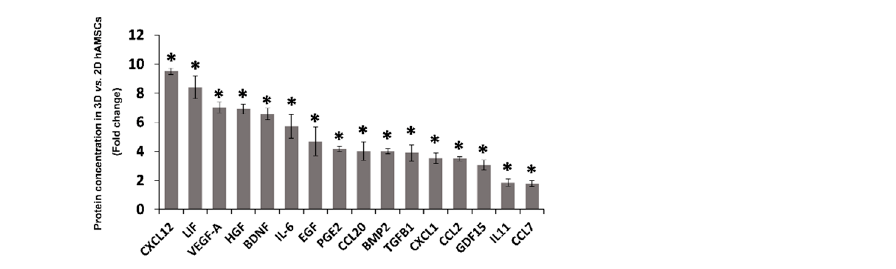
Figure 5. Protein secretion analysis of differentially methylated genes in 2D vs. 3D hAMSCs. * p < 0.05 vs. 2D hAMSCs.